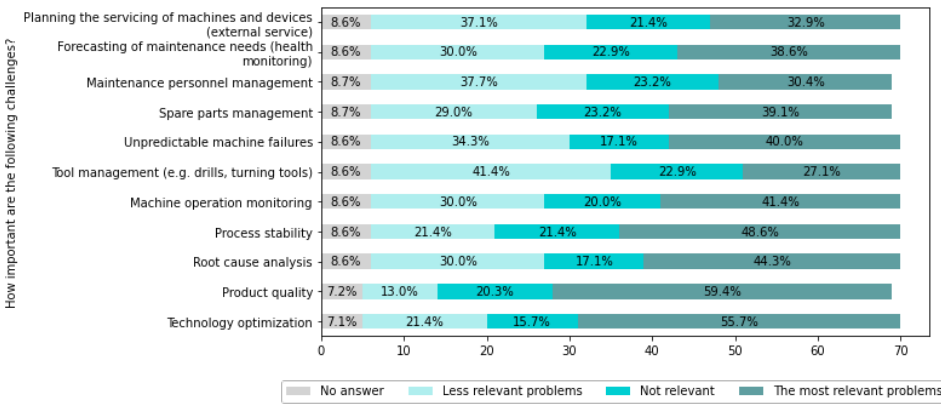
Figure 18. Challenges related to the manufacturing process — number of questionnaires in a total number of 70 questionnaires.